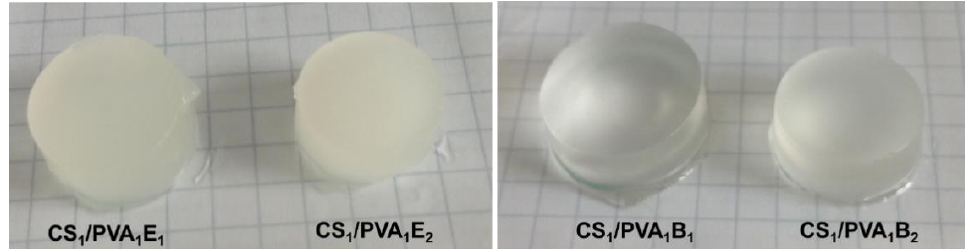
Figure 1. Optical photomicrographs of CS/PVA hydrogels after the last six freeze–thaw cycles and a holding time of 24 h.